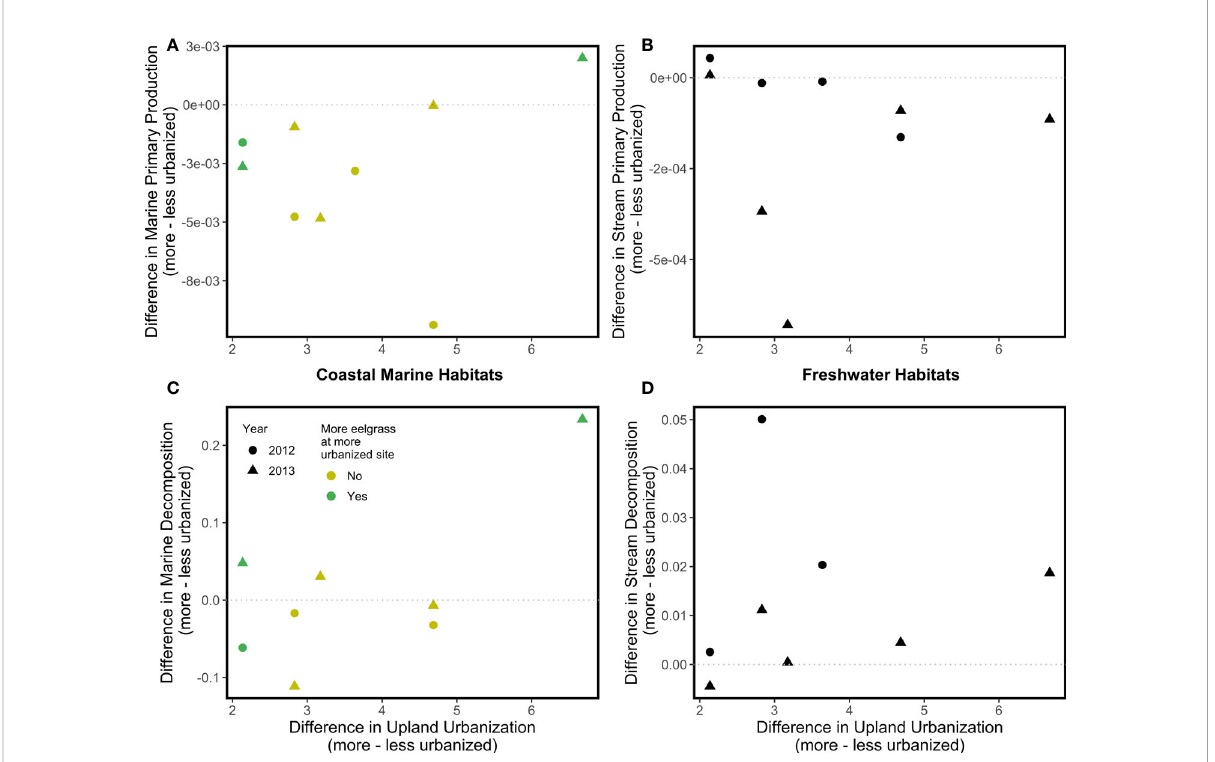
FIGURE 3 Associations between the upland urbanization difference and disparity between more and less urbanized watersheds in two ecosystem functions (top, Net Primary Productivity; bottom, Decomposition) in coastal marine (A, C) and freshwater (B, D) habitats. No regressions were statistically signi fi cant; dotted lines serve as a reference representing zero difference in the ecosystem properties between more and less urbanized